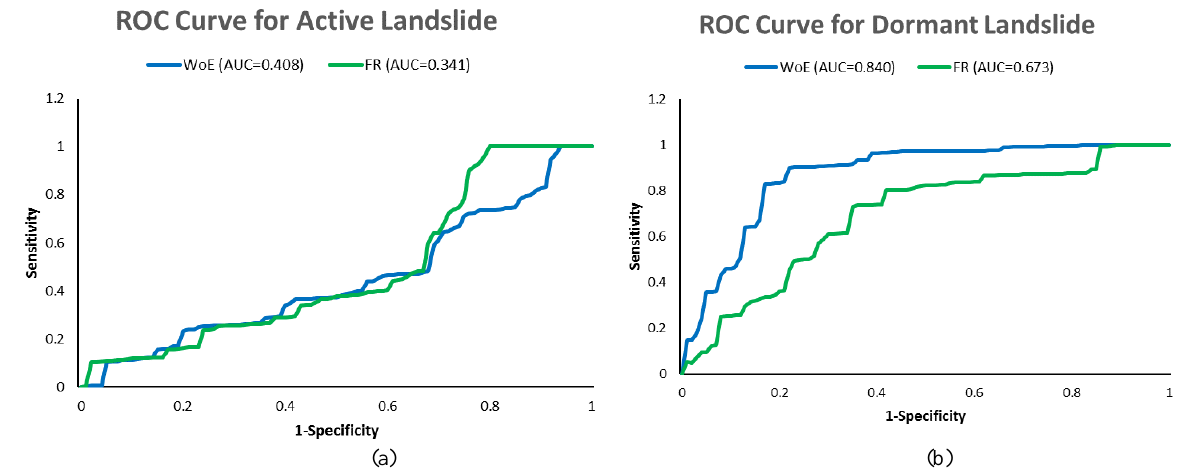
Figure 7. The prediction rate for (a) active and (b) dormant landslide activities for different methods by ROC